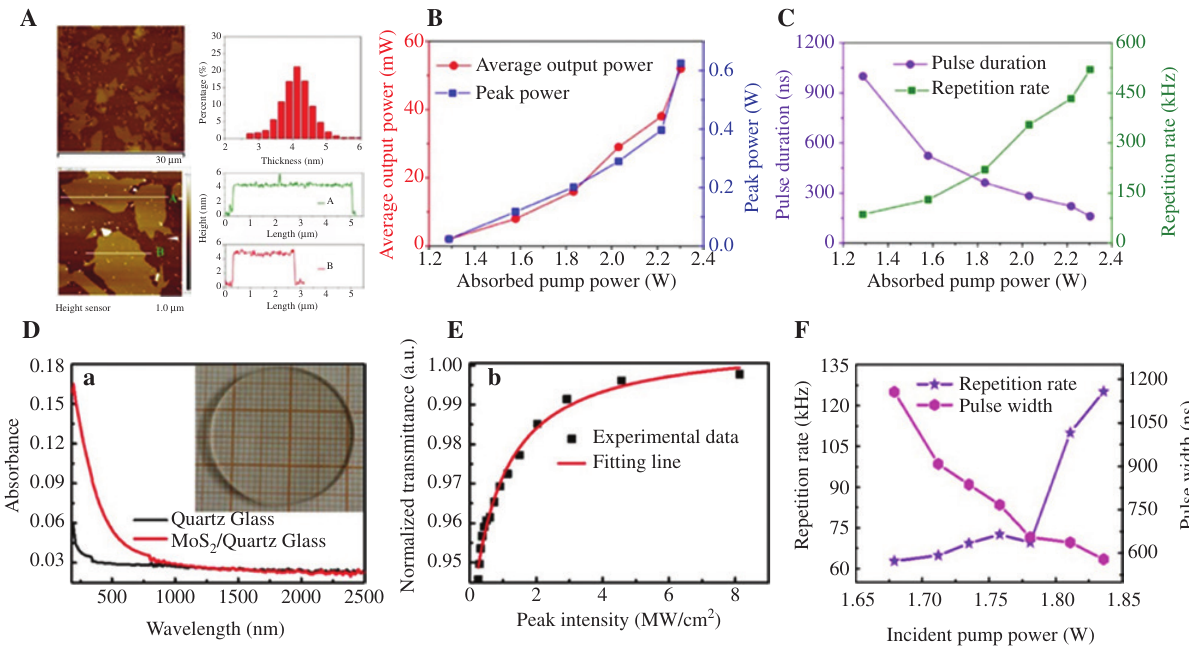
and MoS Q-switched visible lasers. Figure 13: Performance of ReS 2 2 (A) AFM image of the ReS SA and the typical height profiles; (B) average output power, peak power, (C) pulse duration and repetition rate vs. 2 the absorbed pump power of ReS Q-switched 640 nm laser. Reproduced with permission [135]. Copyright 2018, Optical Society of America. 2 (D) Absorbance of the MoS /quartz sample and quartz glass substrate. (Inset) Atomic-layer MoS 2 transmittance with input peak intensity of the MoS SA at wavelength of 522 nm. (F) The repetition rate and pulse width vs. absorbed pump 2 power of MoS Q-switched 522 nm laser. Reproduced with permission [68]. Copyright 2016, IEEE Photonics 2